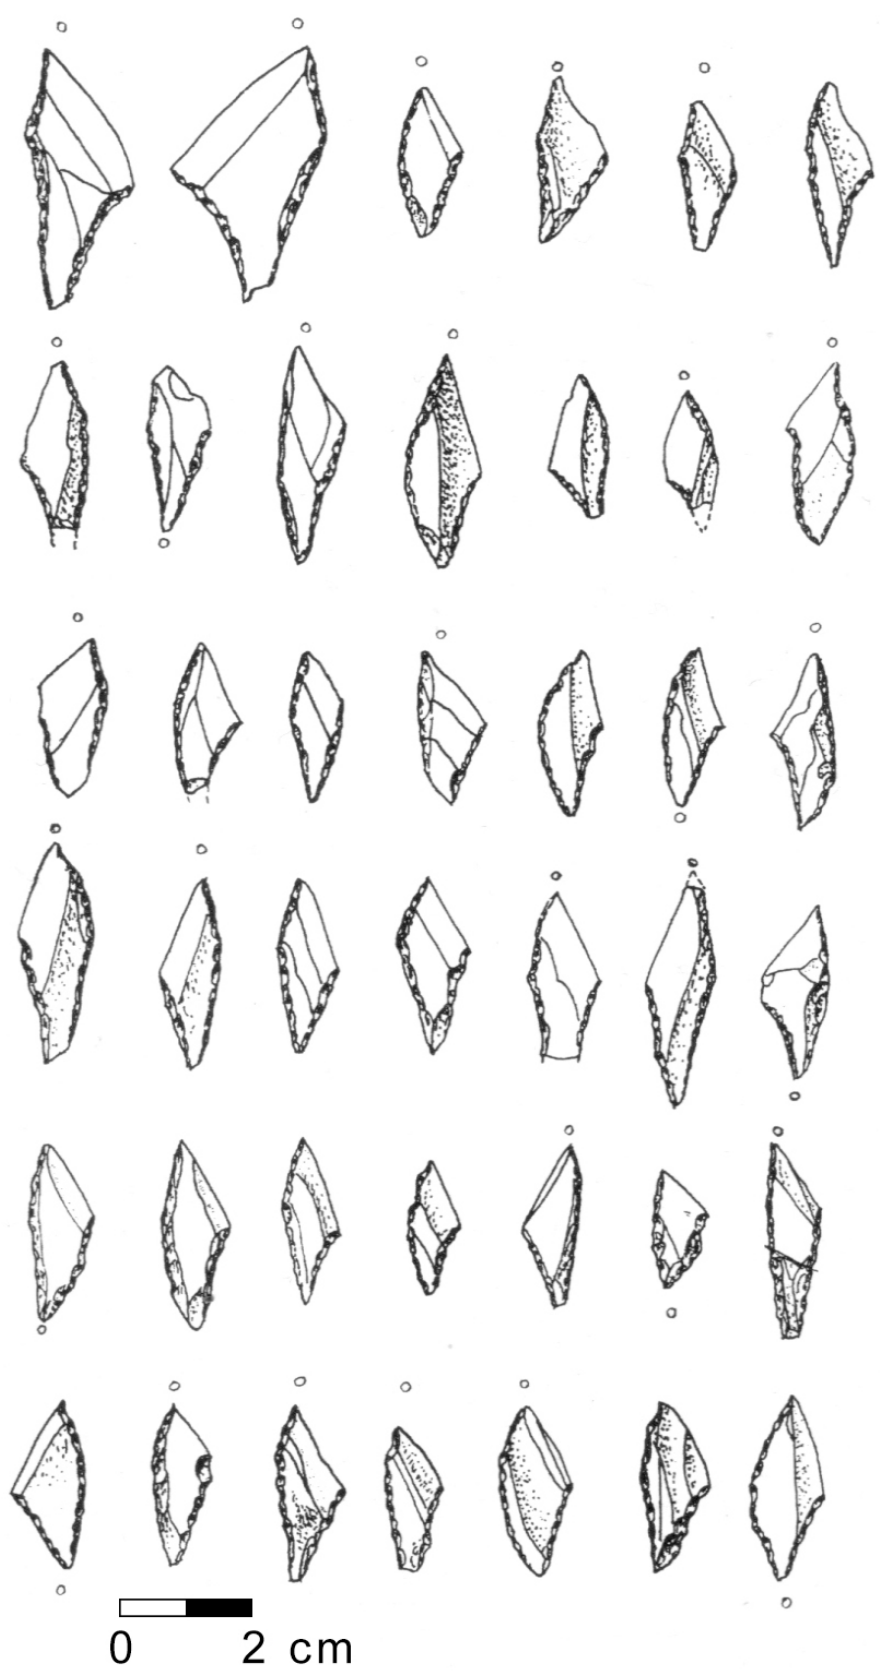
Figure 7. Single-edged points from Tosskärr in western Sweden (Hensbacka Culture) (courtesy of Hans Kindgren (Kindgren 2002: Fig.